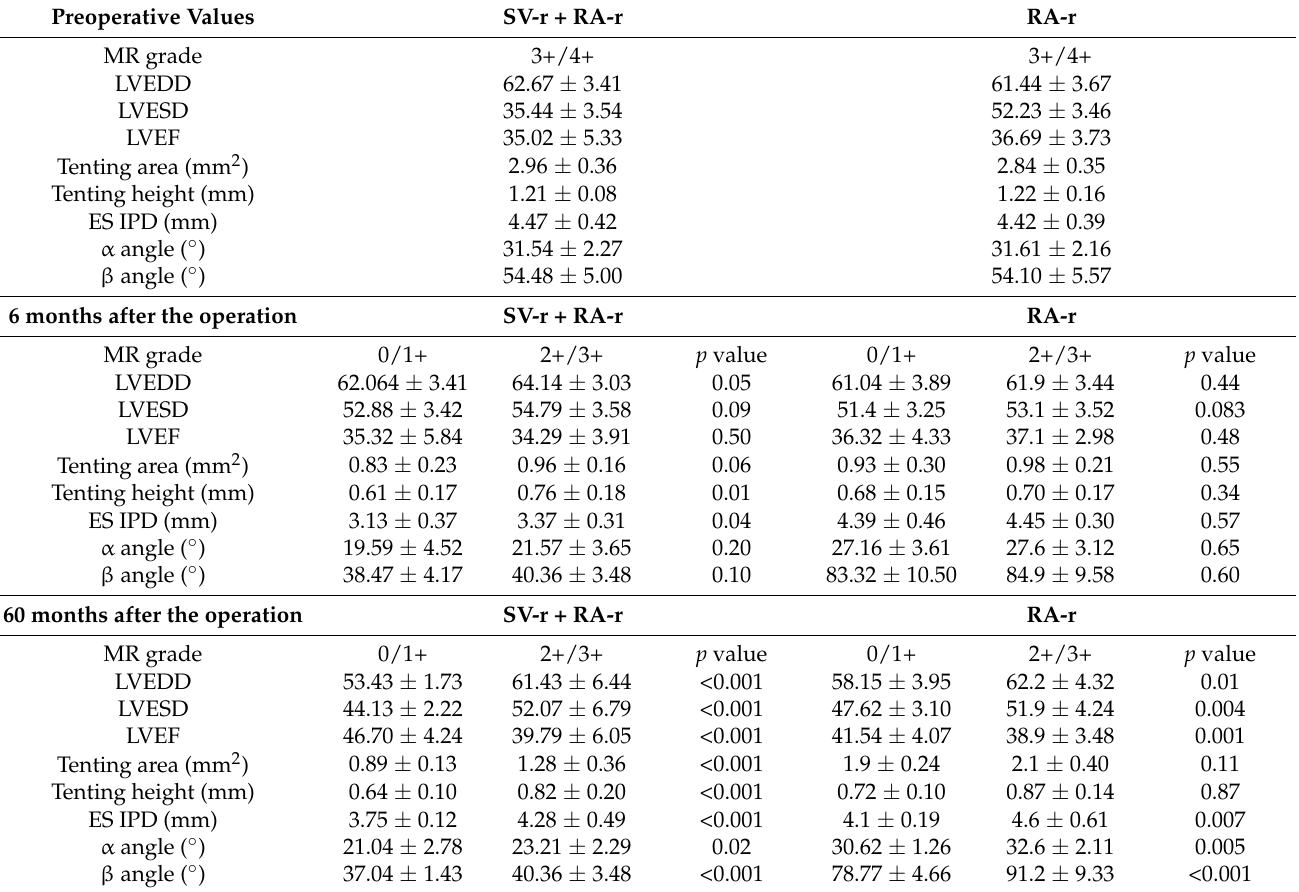
Table 2. LV remodeling and MR at follow-up after SV-r + RA-r and